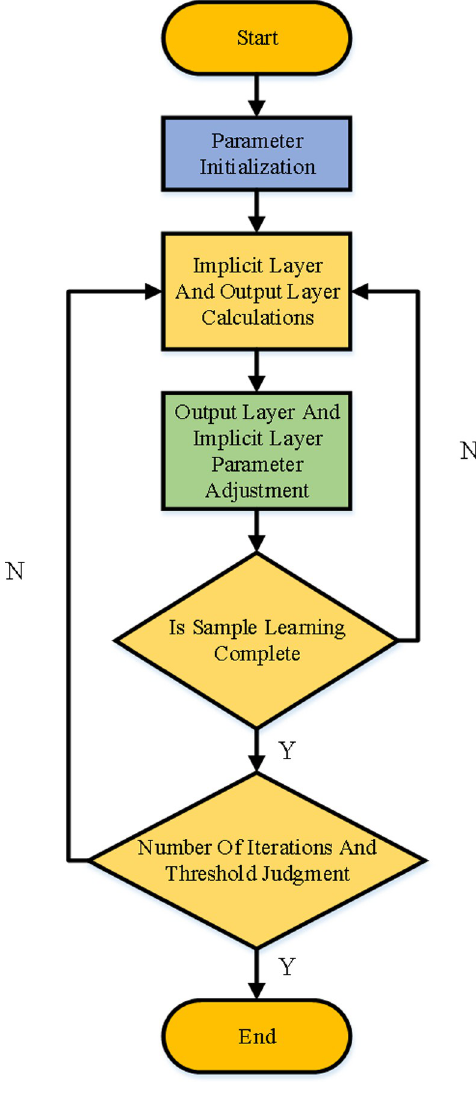
Fig 3. The training process for the salary forecast